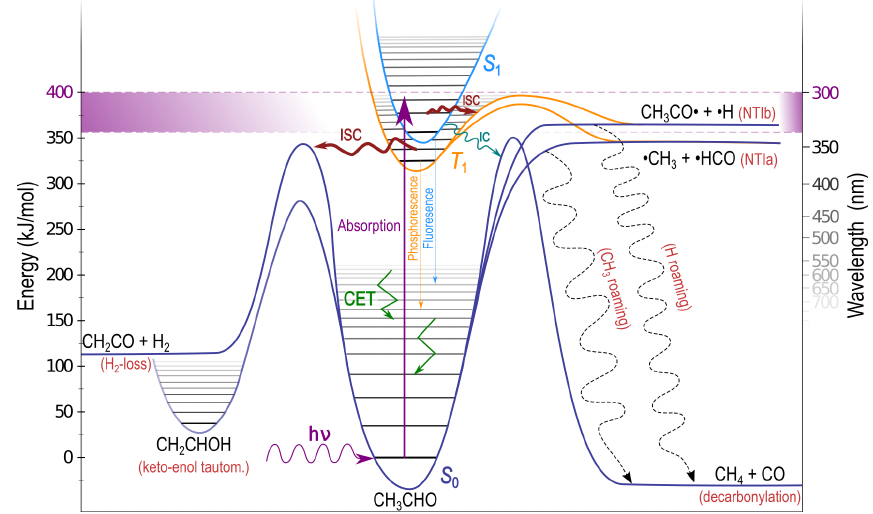
Figure 2. Schematic of the atmospheric fate of acetaldehyde (CH 3 CHO) following absorption of a near-UV photon. Possible outcomes depend on excitation energy and include electronic surface crossing, collisional energy transfer (CET), unimolecular dissociation including roaming (dashed arrows) and